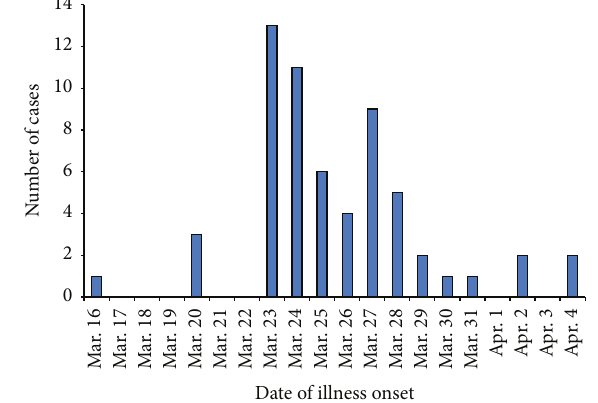
Figure 1: An epidemic curve shows the number of cases during the measles outbreak in Lanzhou University Second Hospital between March16,2016,andApril4,2015.The 𝑥 -axisrepresentsdateofillness onset; the 𝑦 -axis represents the number of